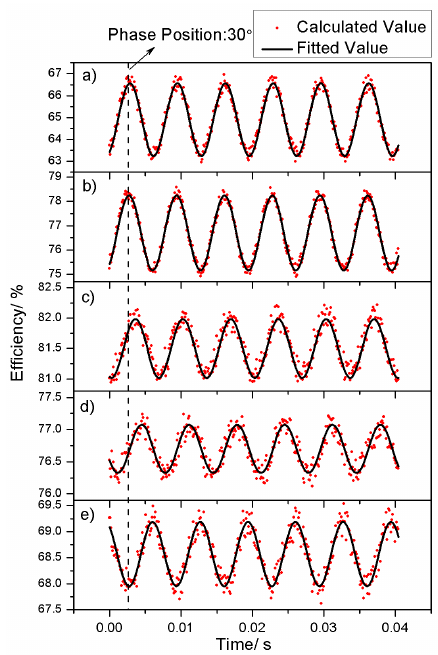
Figure 8. Fluctuation of efficiency in one shaft rotation cycle at different working points: ( a ) 0.6 Q des ; ( b ) 0.8 Q des ; ( c ) 1.0 Q des ; ( d ) 1.2 Q des ; ( e ) 1.4 Q des . Table 3. Fitting parameters for torque fluctuation in different working conditions. B : peak value on the vertical coordinate; C : displacement distance on the vertical coordinate; ω : angular rotational rate of the shaft (rad·s −1 ); φ: initial phase of sine function (rad); R 2 : fitting optimization index.